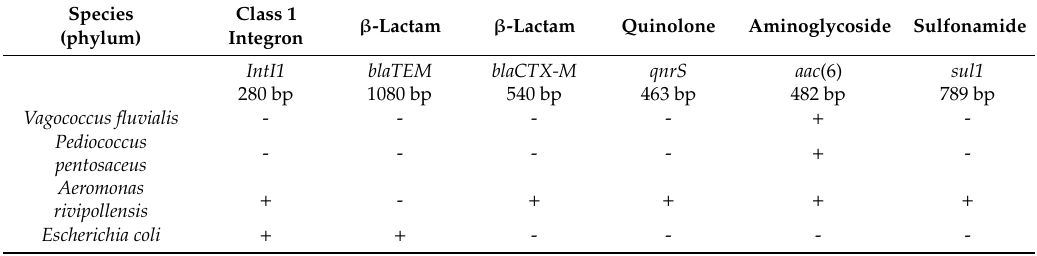
Table 7. Ciprofloxacin enrichment cultures: identification and antibiotic resistance genes. Species